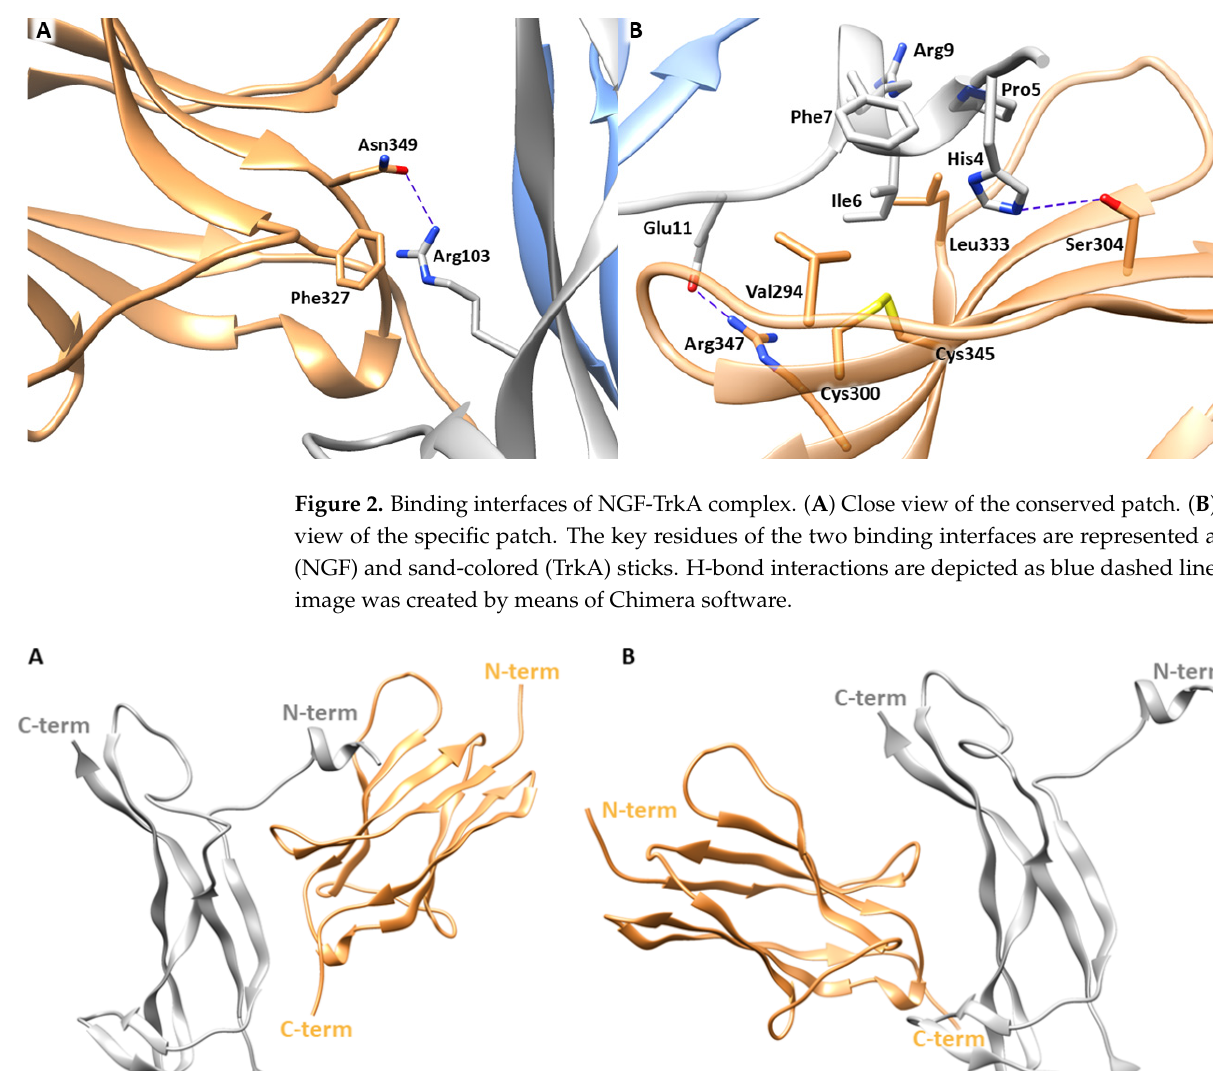
Figure 2. Binding interfaces of NGF-TrkA complex. ( A ) Close view of the conserved patch. ( B ) Close view of the specific patch. The key residues of the two binding interfaces are represented as grey (NGF) and sand-colored (TrkA) sticks. H-bond interactions are depicted as blue dashed lines. The image was created by means of Chimera software.